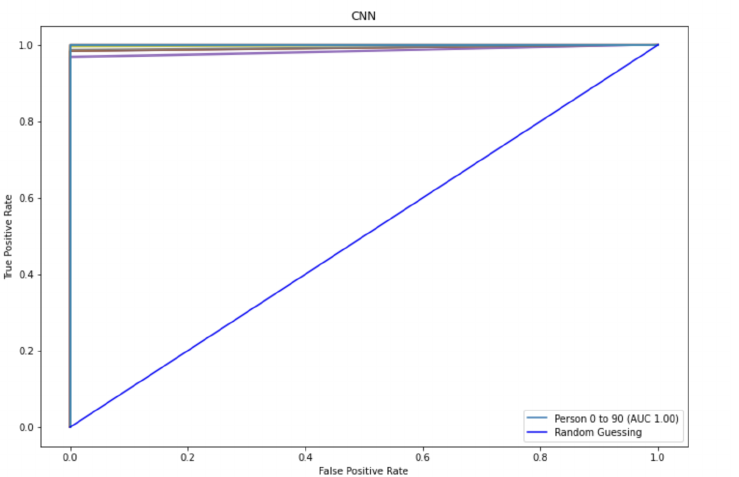
Figure 10. Represents the area under the curve score for the proposed CNN